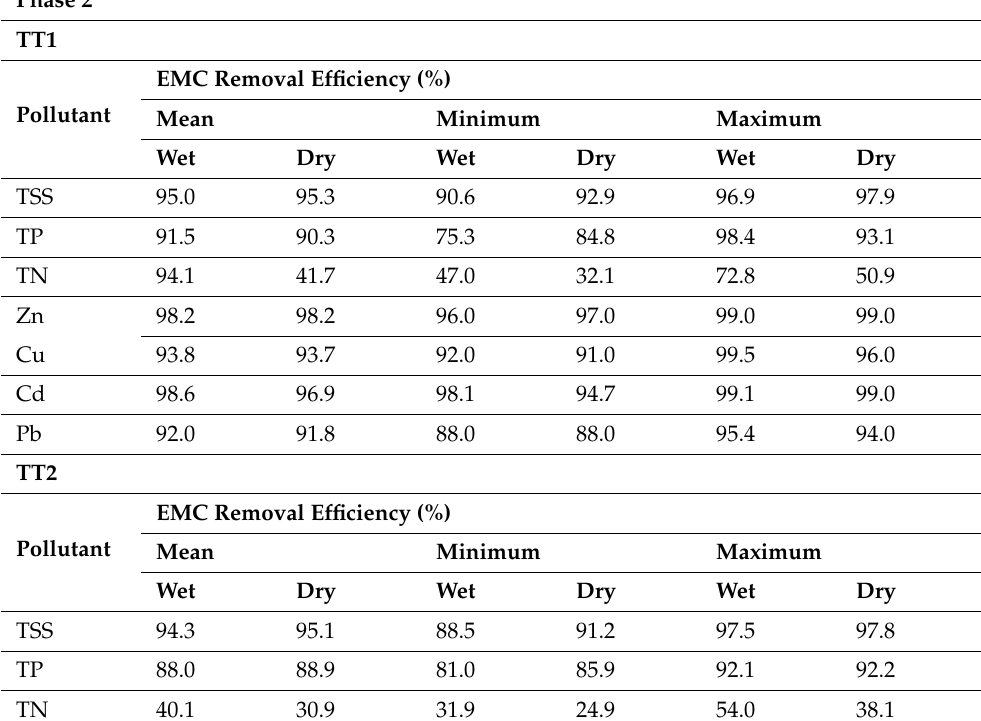
Table A5. EMC removal efficiency of pilot bioretention tree biofilter study (TT1: Talipariti tiliaceum ; TT2: Sterculia macrophylla ) for Phase 2.